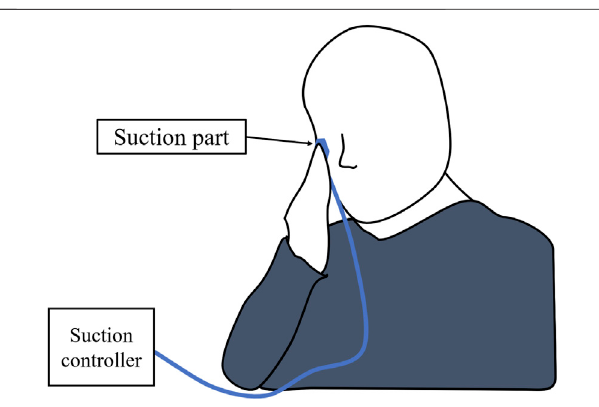
FIGURE 5 | The experimental setup. The participant placed the suction part on their